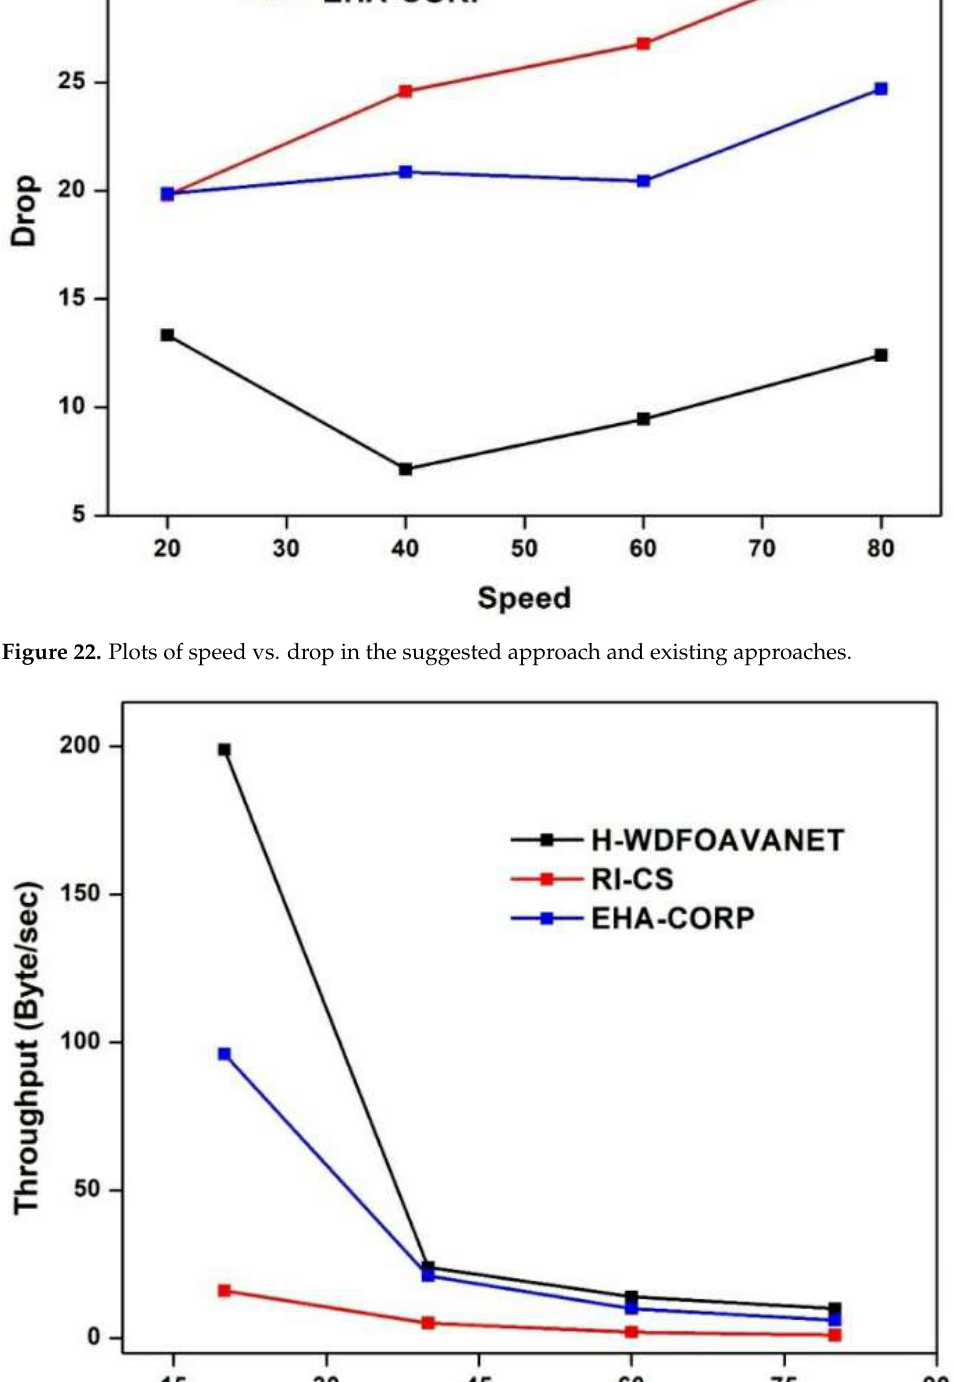
Figure 23. Plots of speed vs. throughput in the suggested approach and existing